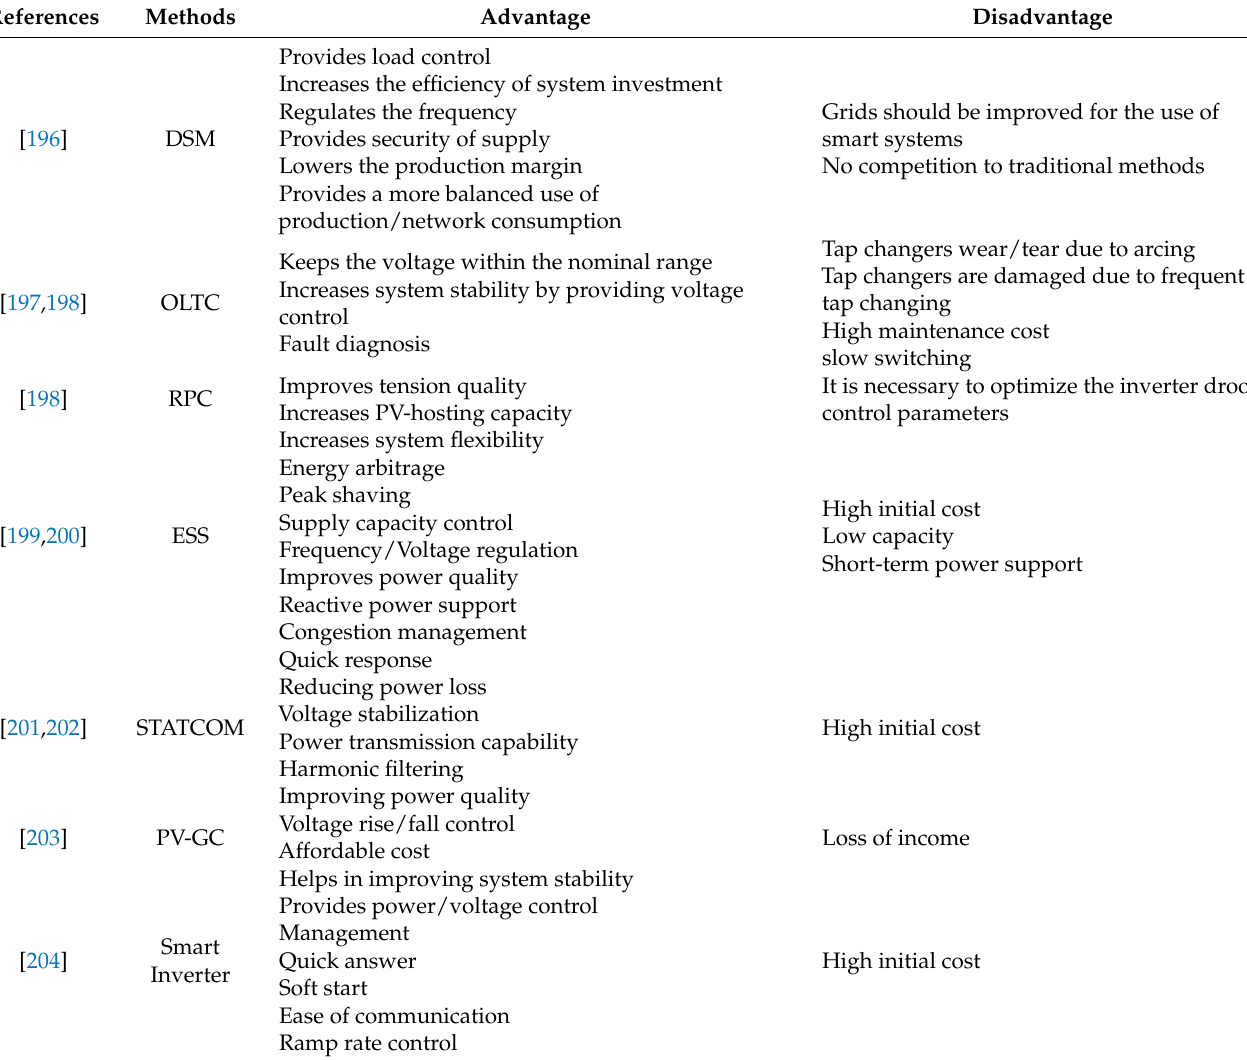
Table 8. Comparison of Advantages and Disadvantages among common